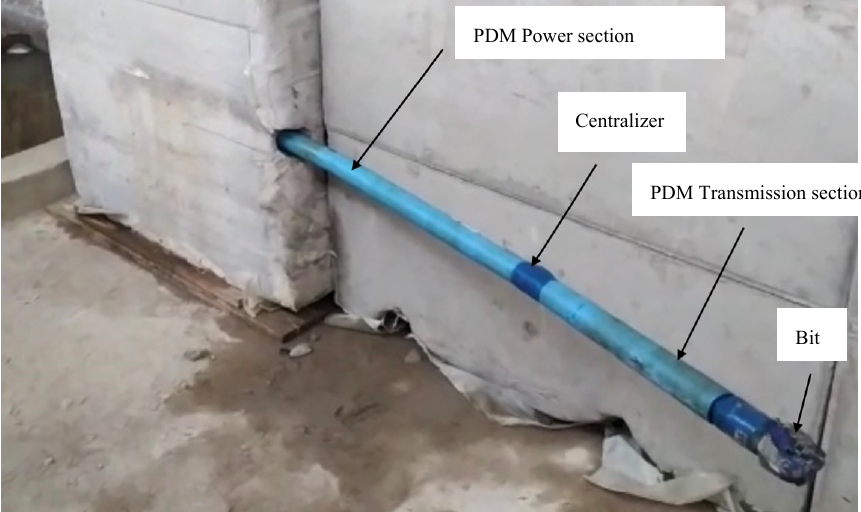
Figure 3. Photo of a two-section PDM with TS Perfobore centralizers.